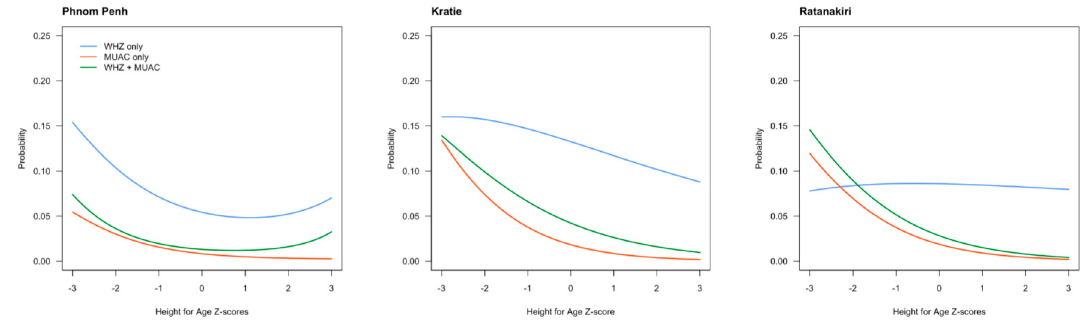
Figure 3. Probability of being diagnosed with acute malnutrition using WHZ scores, MUAC, or both combined as an indicator, in relation to height-for-age Z score (HAZ) in children living in Phnom Penh, Kratie, or Ratanakiri.